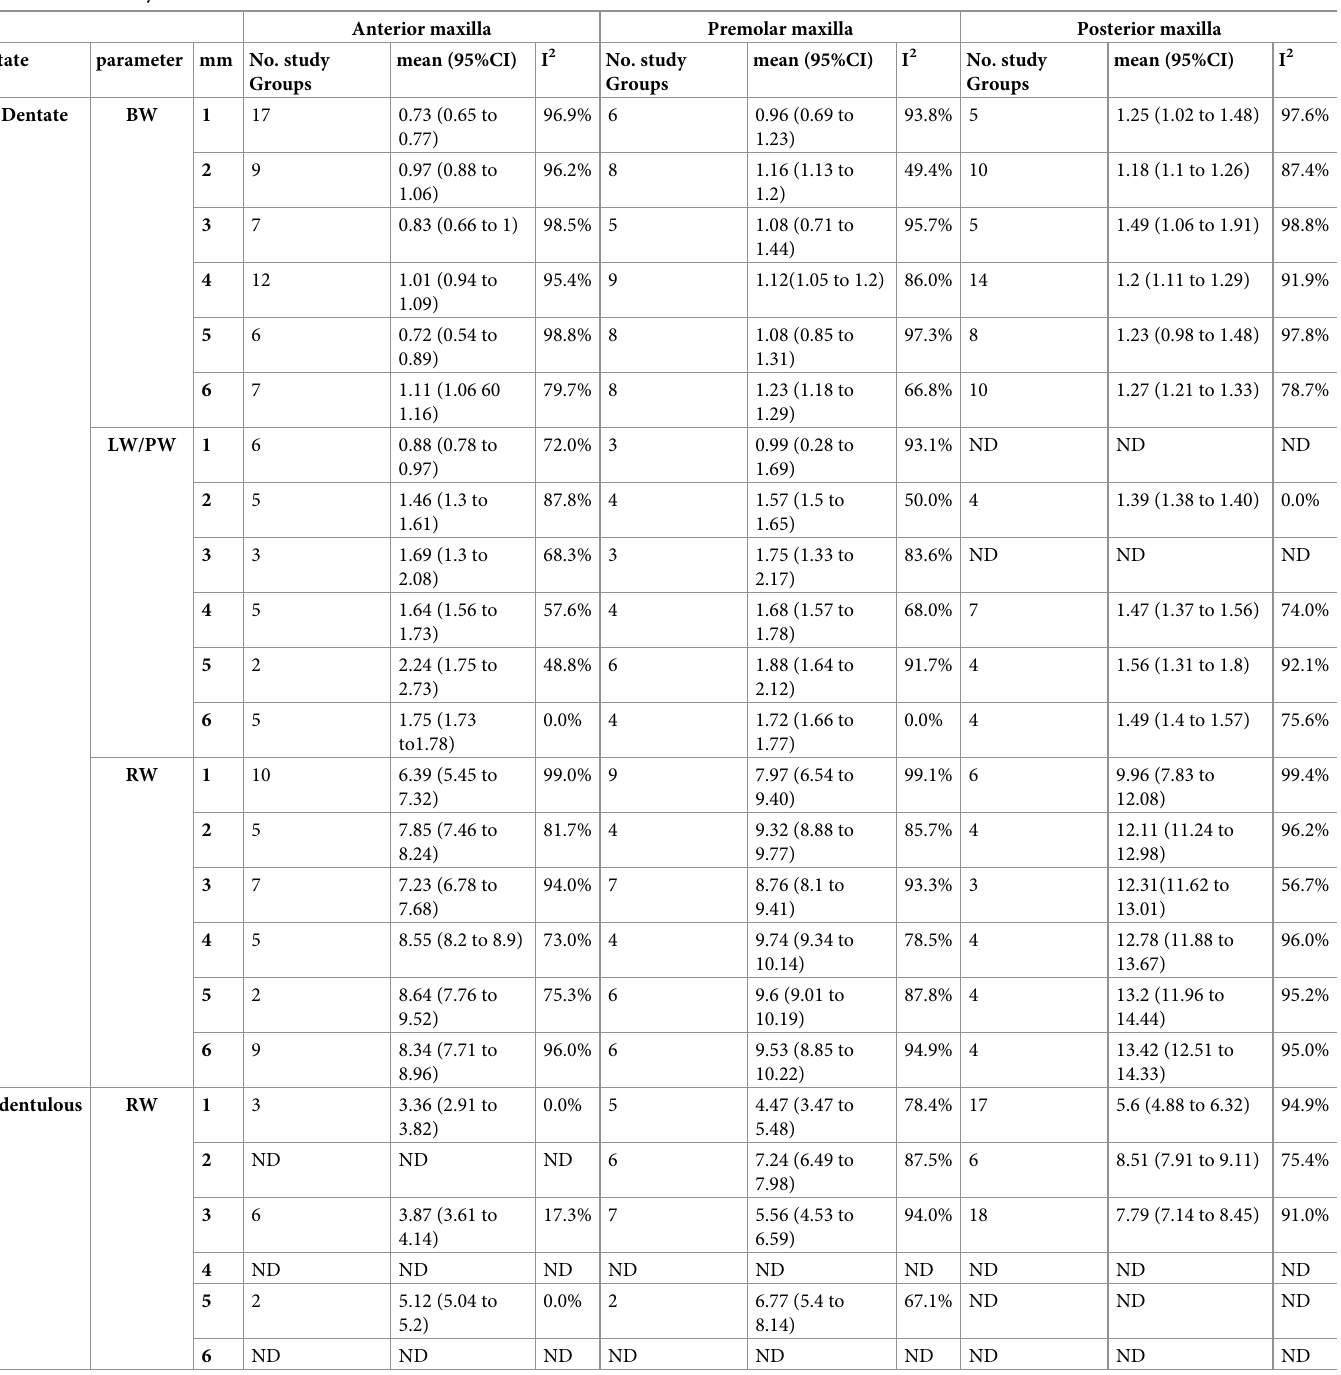
Table 1. Meta-analysis result for the